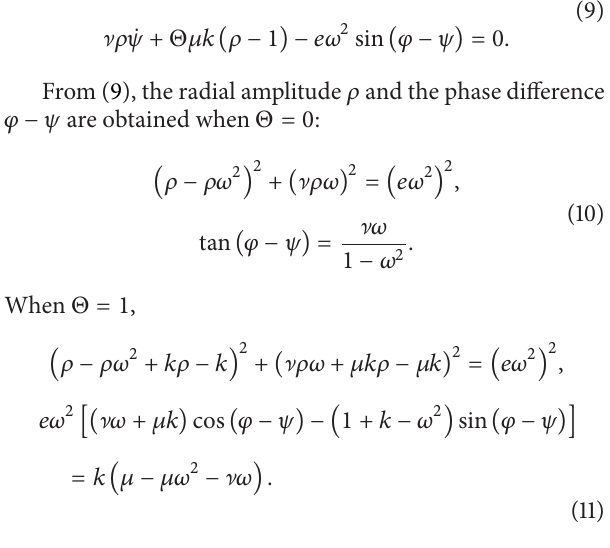
The rotor/stator system governed by (1) has a steady-state periodic solution that has constant amplitude and a frequency equal to the rotating speed of the rotor. The solution is corresponding to ̈𝜌 = ̇𝜌 = ̈𝜓 = 0 and ̇𝜓 = ̇𝜑 = 𝜔 ; substituting this specific solution into (1)